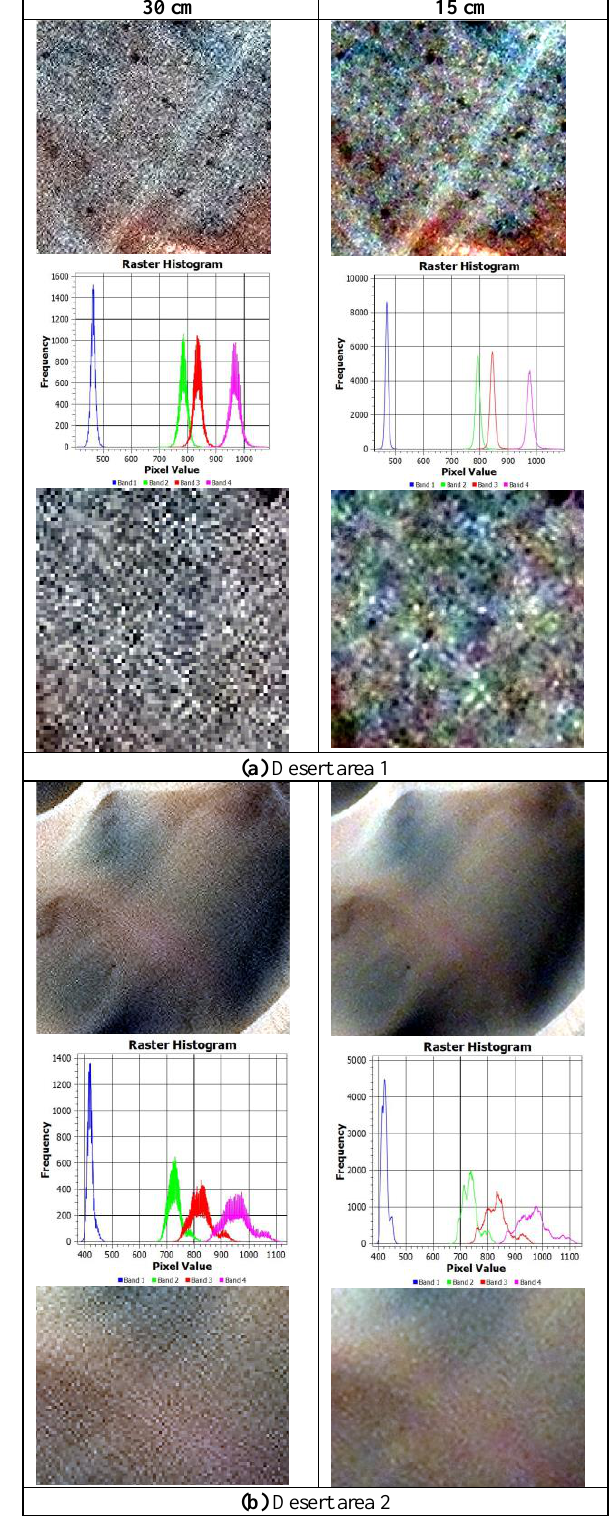
Figure 13. MAXAR 30 cm (left) and 15 cm (right) image parts over two desert areas (a and b) in Al